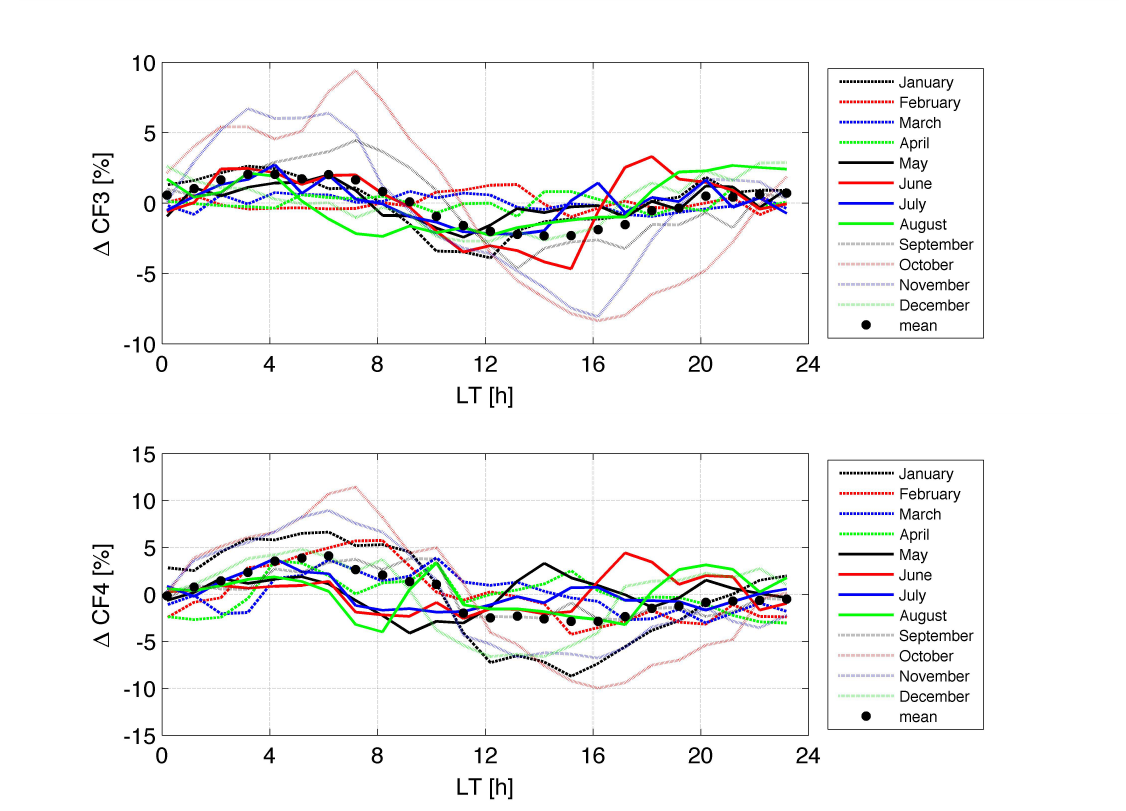
Figure 8. Seasonal dependence of the diurnal cycle in cloud fraction ∆ CF3 (warm thick liquid water clouds) and ∆ CF4 (all liquid water clouds) as a function of local time over Bern for the time interval 2004–2016. The panels show ∆ CF = (CF − monthly mean of CF). The black dots indicate the annual mean of the seasonal